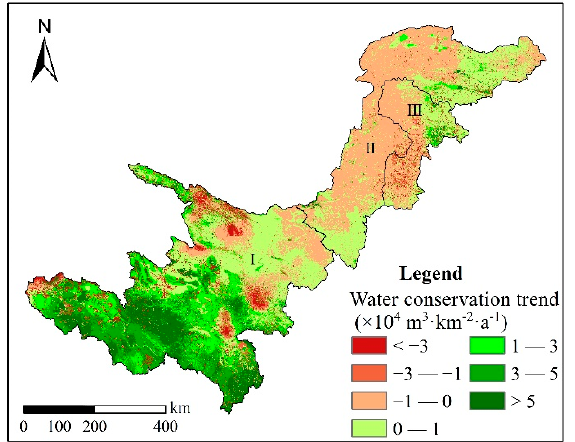
Figure 4. Spatial distribution of the water conservation change rate in the Upper Yellow River region.